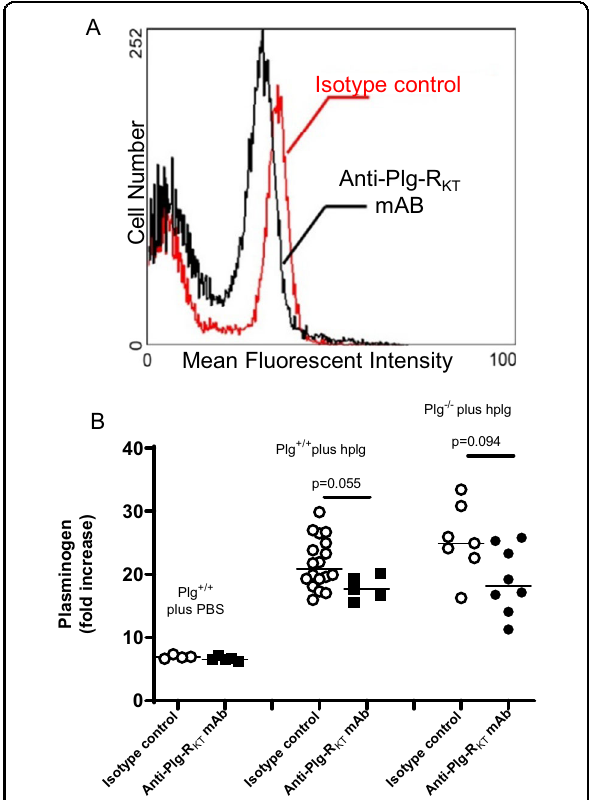
Fig. 2 Role of Plg-R KT in plasminogen accumulation in wounds. A Effect of anti- Plg-R KT mAB on plasminogen binding to the surfaces of leukocytes. Plg + / + and Plg − / − mice (8 – 12 weeks of age) were intravenously injected with 100 µl of anti-Plg-R KT mAB7H1 (2.5 mg/ml) or with mouse IgG2A (2.5 mg/ml) as isotype control (n = 3 for each study group). Thirty minutes later, standard burn wounds were introduced and all mice were intravenously injected with 100 µl (2 mg) of Alexa Fluor 488-labeled human plasminogen or PBS (as control). At 24 h after wounding and injection, blood samples